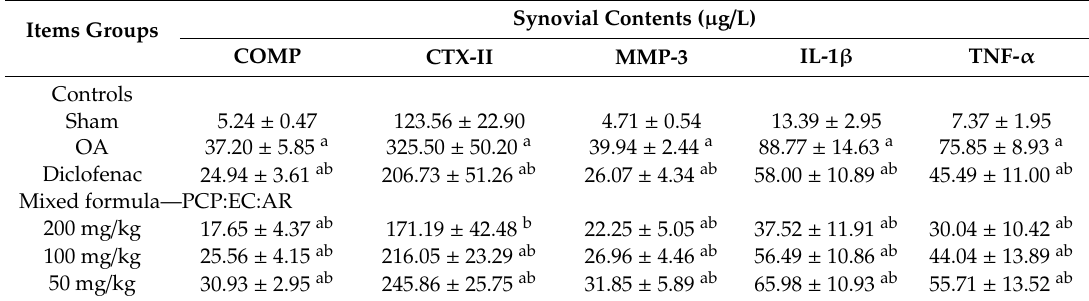
Table 4. Synovial COMP, CTX-II, MMP-3, IL-1 β , and TNF- α content in sham-operated or OA rabbits.